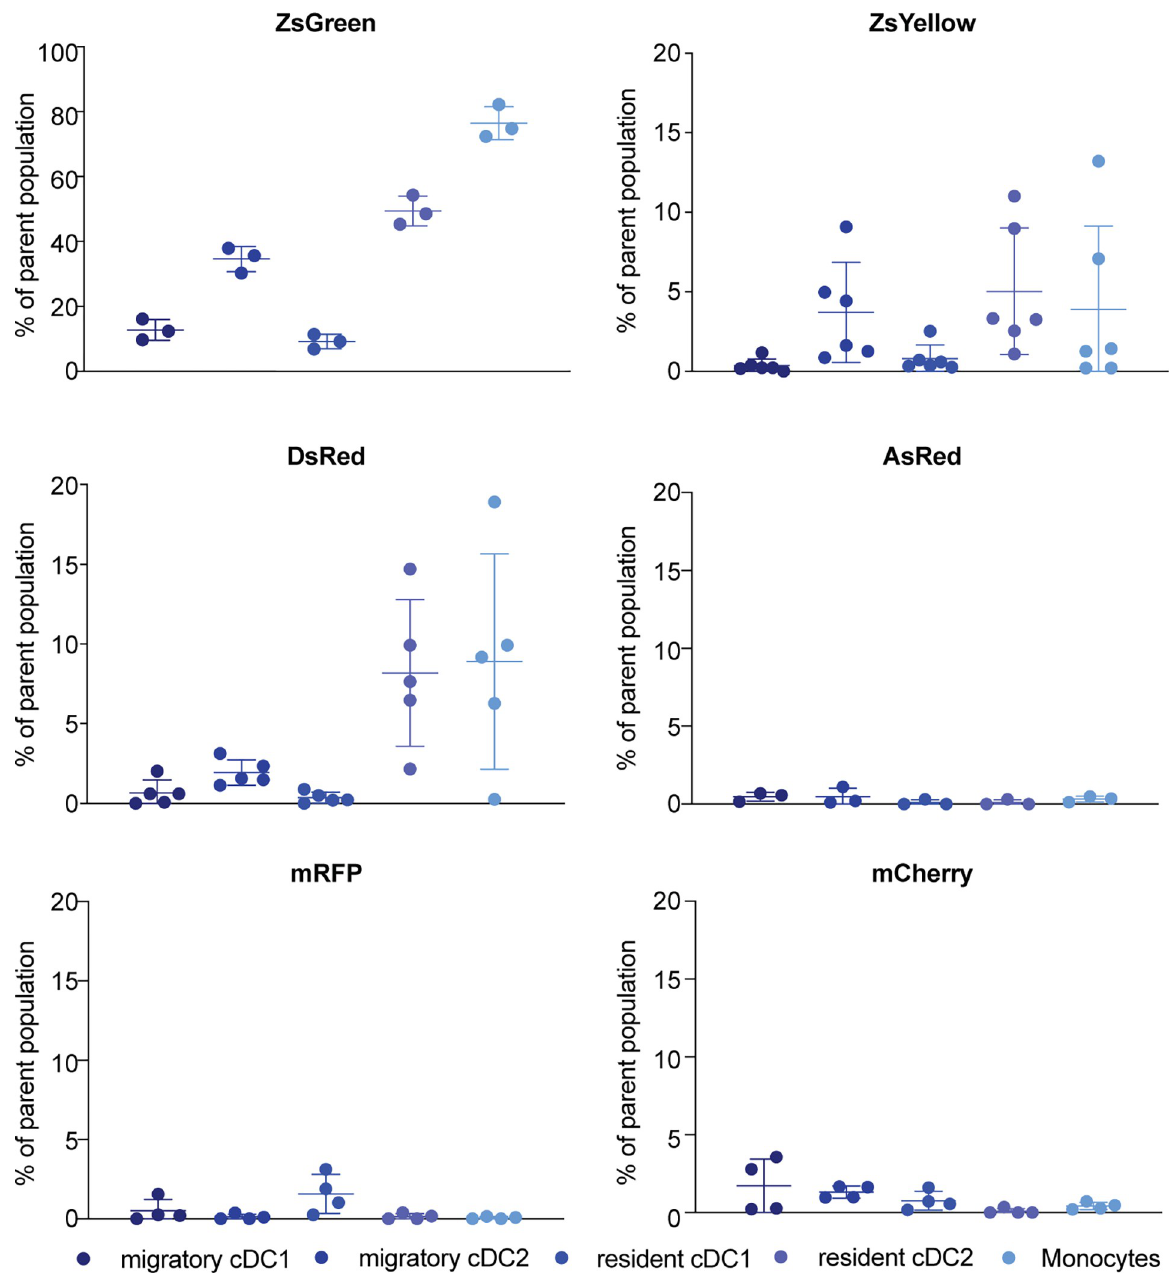
Fig 6. Limited detection of other non-ZsGreen fluorescent proteins within immune cells of tumor draining lymph nodes. Tumor draining (inguinal and axillary) lymph nodes were harvested, processed, and analyzed through flow cytometry. Non-fluorescent control (B16-F10) was used to set the threshold for FP positivity. One representative example of three independent experiments is